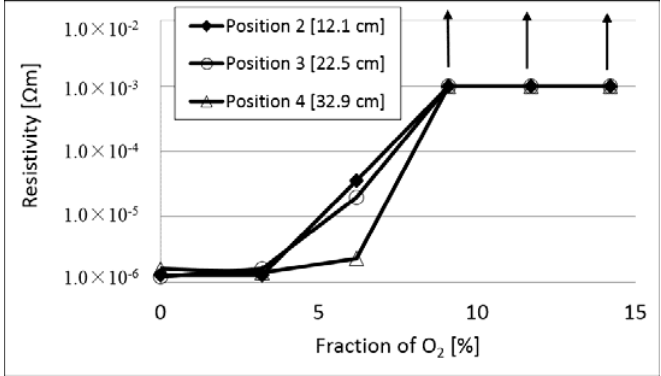
Figure 5. Relation between the resistivity and the fraction of O 2 (%) in the case without the Al outer anode at different positions.